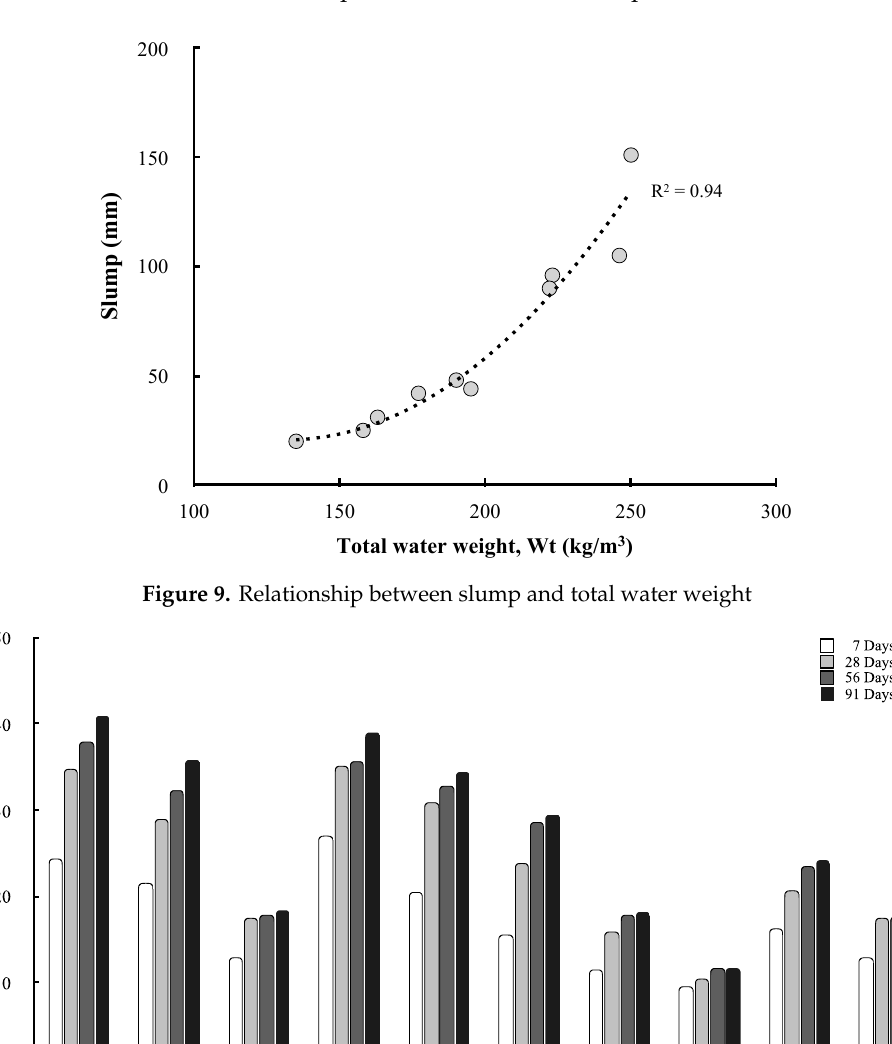
Figure 8. Water weight in mix proportion according to LRM mixing method